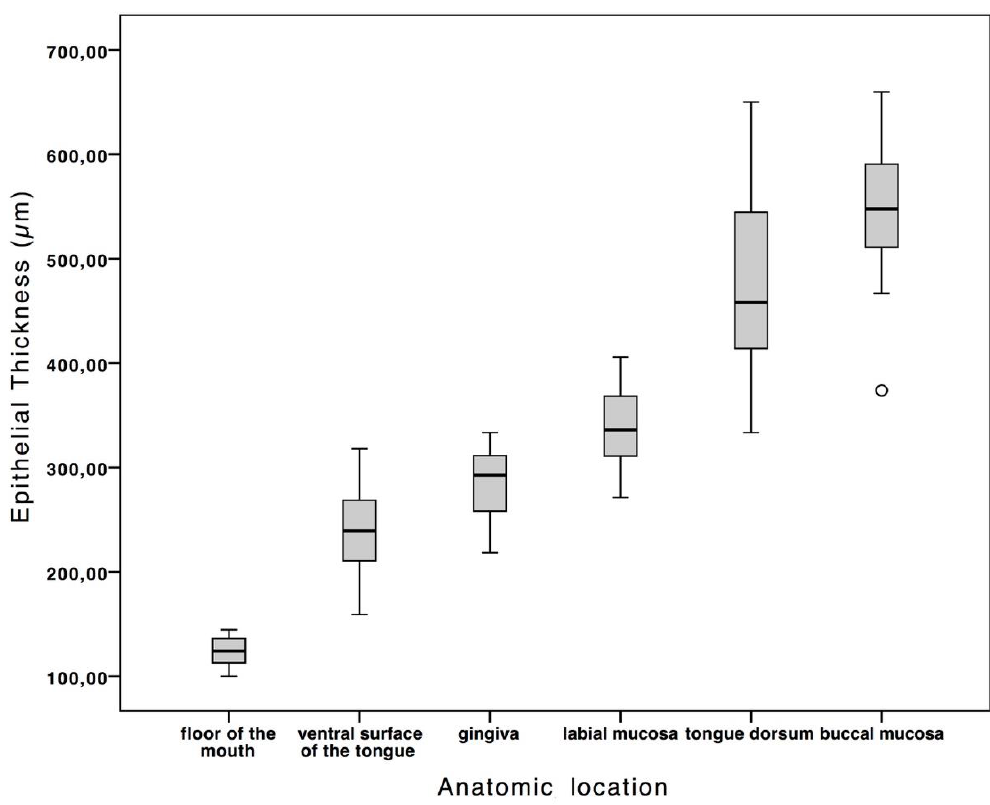
Figure 2. The box plot shows the normal values of epithelial thickness according to anatomic location. The difference in epithelial thickness between the different anatomical locations was statistically significant— p ≤ 0.05 .